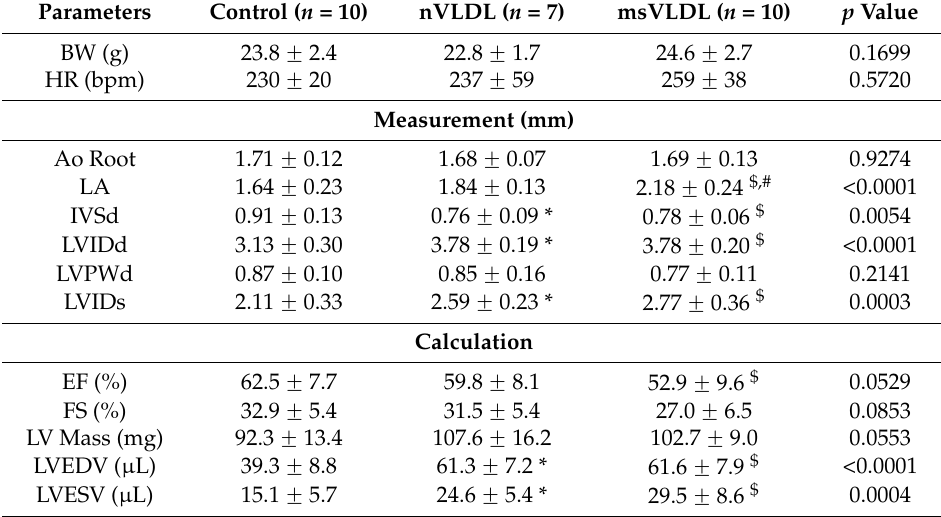
Table 1. Echocardiography results after six weeks of very low density lipoproteins (VLDL) injection. Parameters